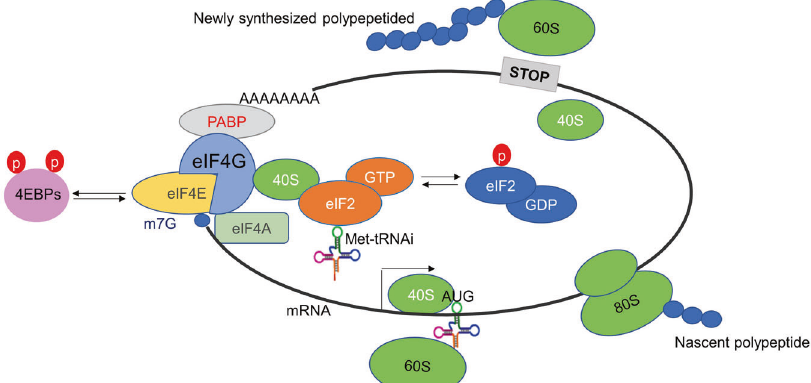
Fig. 2 The model of protein translation process. Translation is initiated by eIF4F assembly, consists of eIF4A, eIF4E, and eIF4G. The hypophosphorylated form of 4E-BPs competes with eIF4G to bind eIF4E, and phosphorylated eIF2 α fails to recover the GTP required for Met- tRNAi, resulting in failure of the formation of eIF4F complexes and inhibits translation. Extension: the initiation complex of cap-dependent translation scans the mRNA from the 5 ‘ end to fi nd the fi rst start codon (AUG), and enters the ribosomal P-site via initiator methionyl tRNA (Met-tRNAi). Termination: when the mRNA with stop codon (UAG, UGA, UAA) enters the ribosomal A-site, it can ’ t be recognized by activated amino acid (aa-tRNA), the translation process is fi